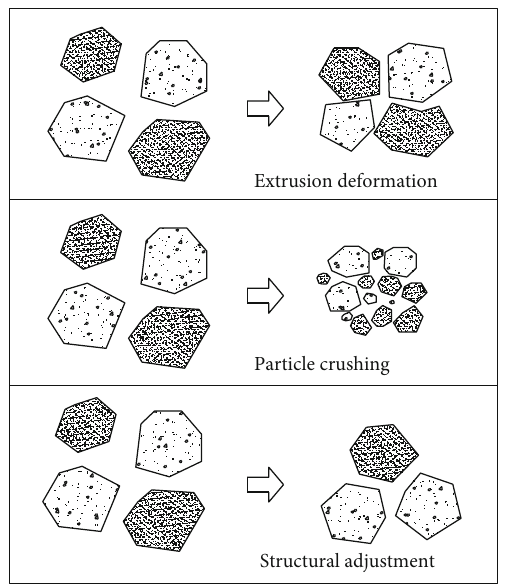
Figure 5: Three di ff erent processes occurring during loading and unloading of broken coal and rock mass samples.